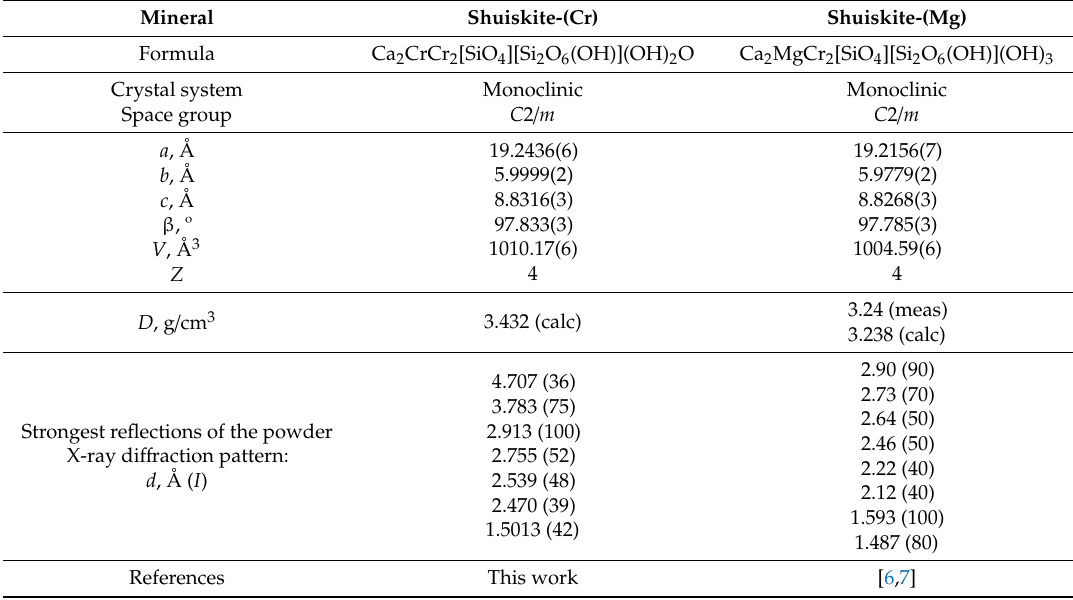
Table 7. Comparative data for shuiskite-(Cr) and shuiskite-(Mg).